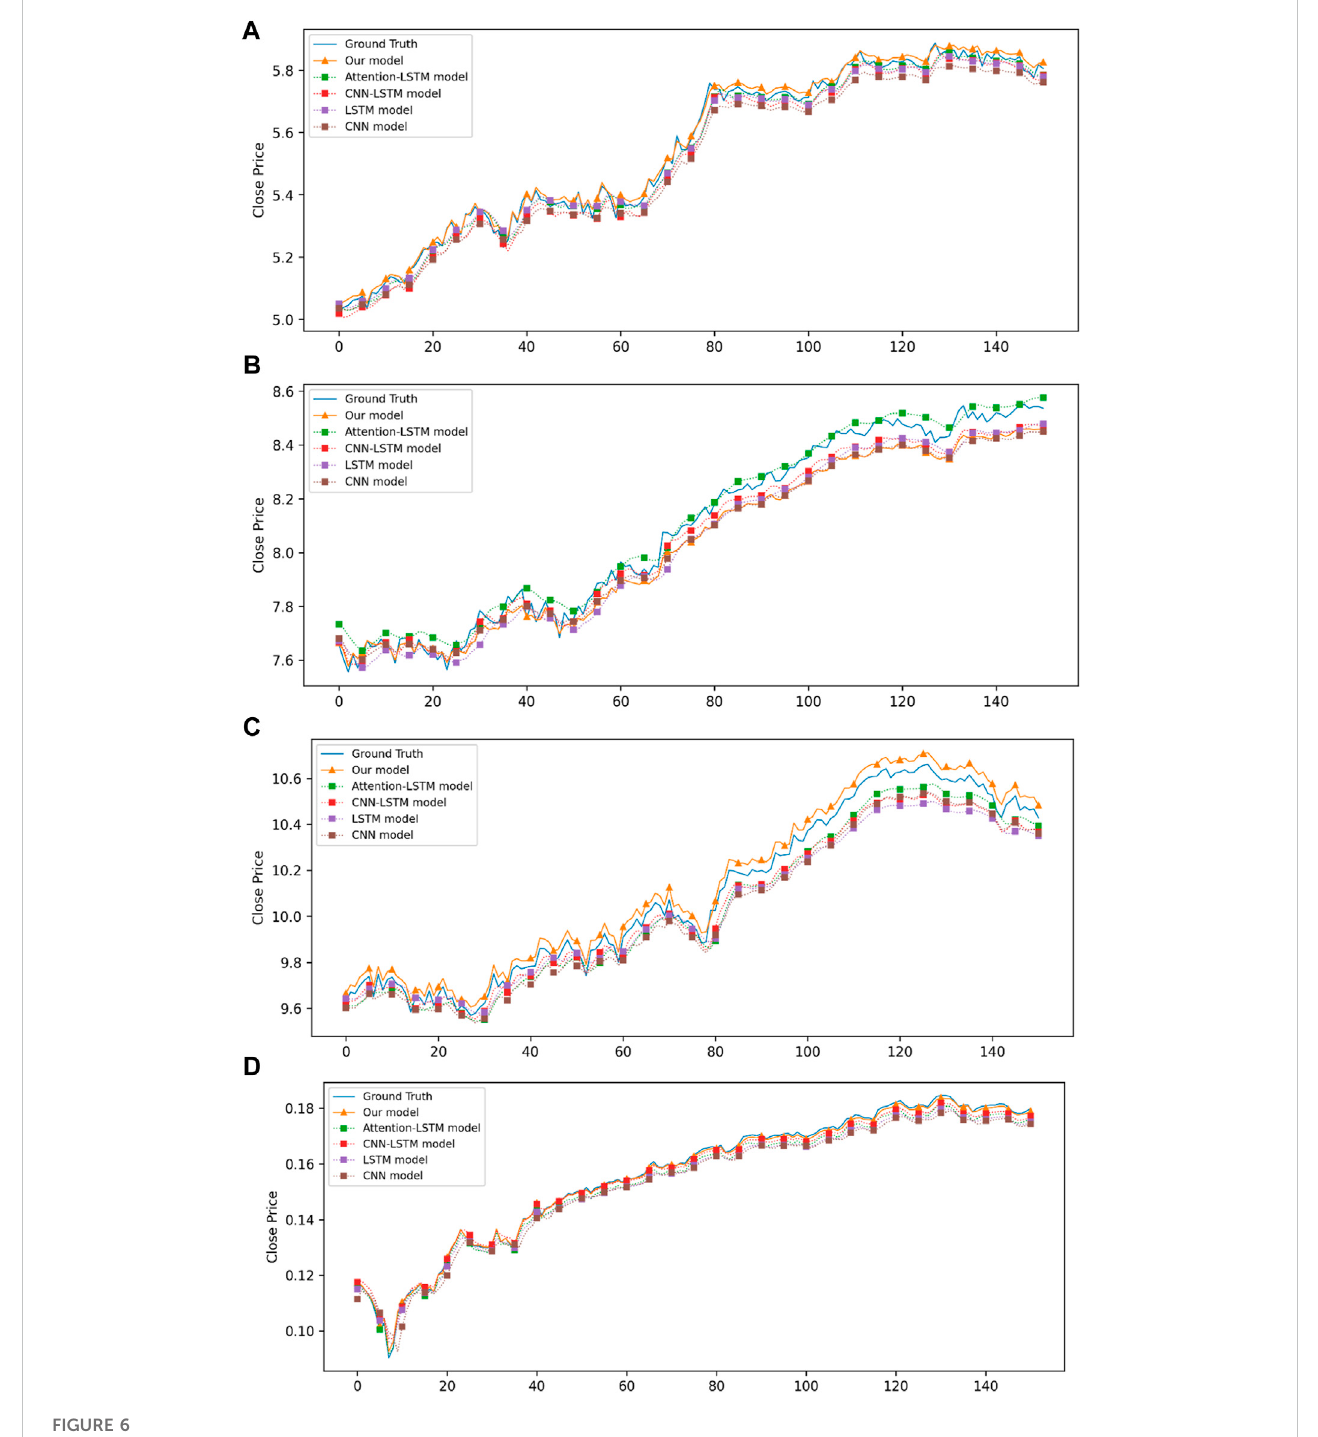
FIGURE 6 Plots of prediction results of each comparison